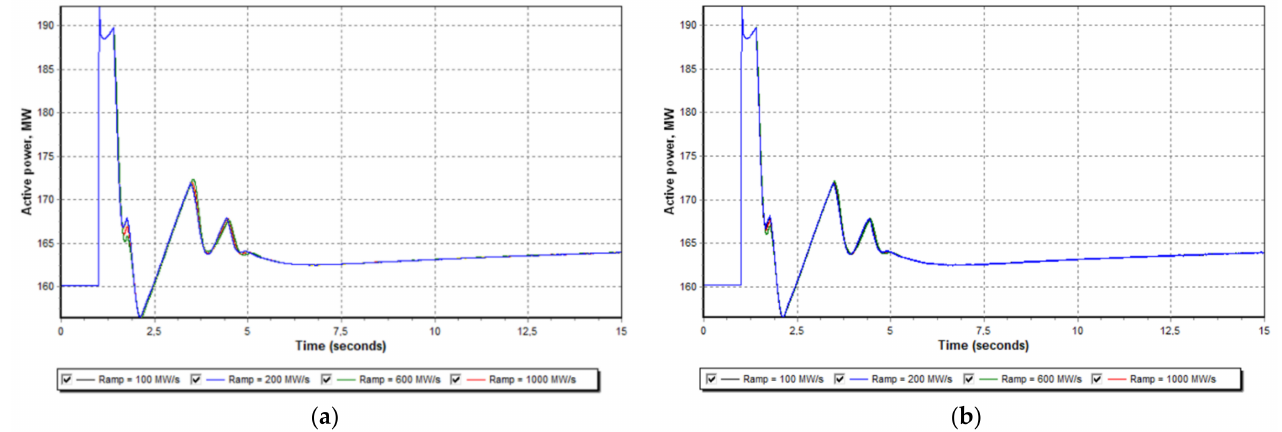
Figure 12. ( a ) The response of an active power to a load change when the gain is K = 1250 MW/Hz. ( b ) The response of an active power to a load change when the gain is K = 2500